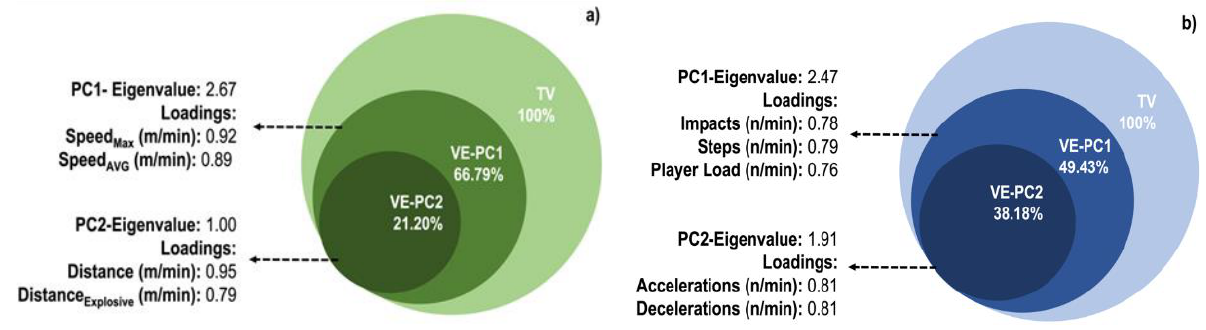
Figure 1. Principal components analysis clustering representation of ( a ) spatio-temporal and ( b ) mechanical workload variables. TV: total variance, VE: variance explained, PC: principal compo- nent.